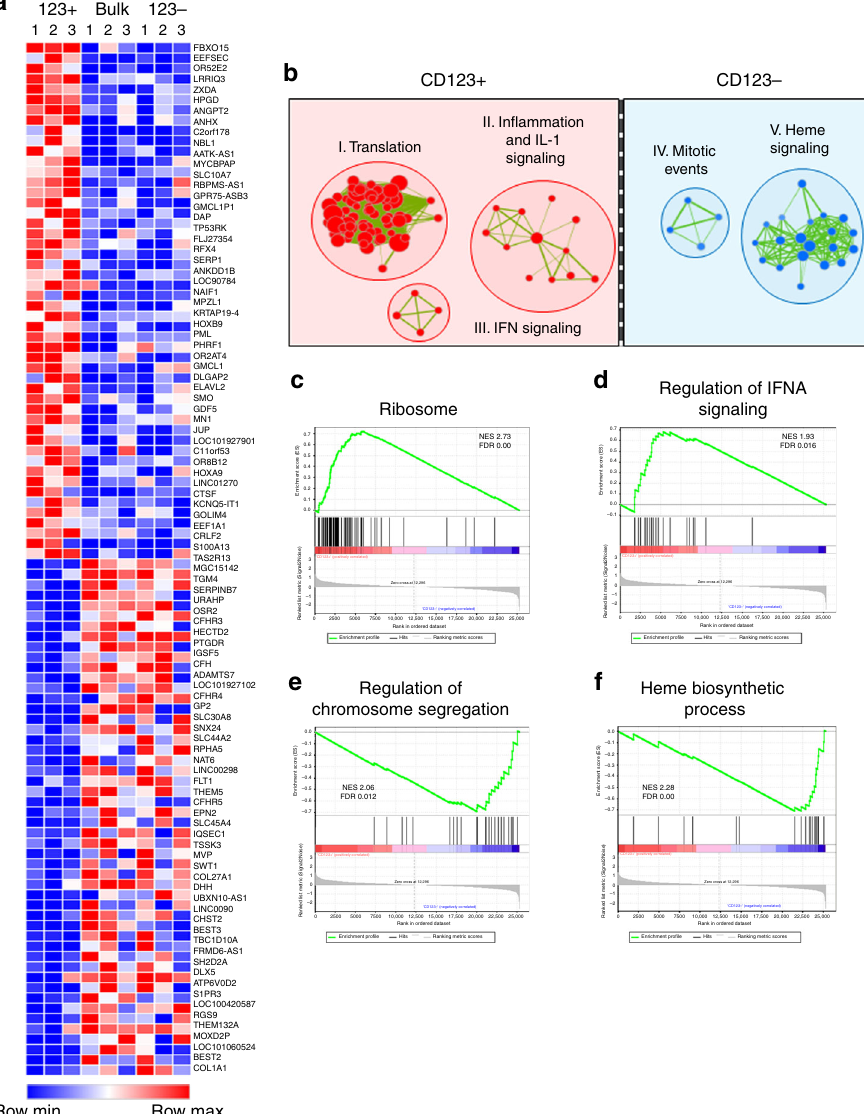
Fig. 2 Whole-transcriptome analysis shows an upregulation of ribosome signaling in CD123 + MDS cells. RNA-seq was performed on Lin − /CD34 + /CD38 − /CD123 + or Lin − /CD34 + /CD38 − /CD123 − primary MDS BM cells from three independent patients. a Heat map shows the top 50 up and downregulated genes. b Using Enrichment map algorithm, top pathways and groups of pathways were delineated in CD123 + vs. CD123 − cells. c – f Using the KEGG database, the ribosome signature was the most signi fi cantly enriched gene set in the translation cluster of nodes in CD123 + cells (panel b ). d The Regulation of IFNA Signaling gene set was also highly enriched in IL1 signaling group of nodes in CD123 + cells. e The Regulation of Chromosome Segregation was highly enriched in the mitotic events cluster of nodes in CD123- cells. f The Heme Biosynthetic Process pathway was highly enriched in the Heme signaling pathway in CD123-